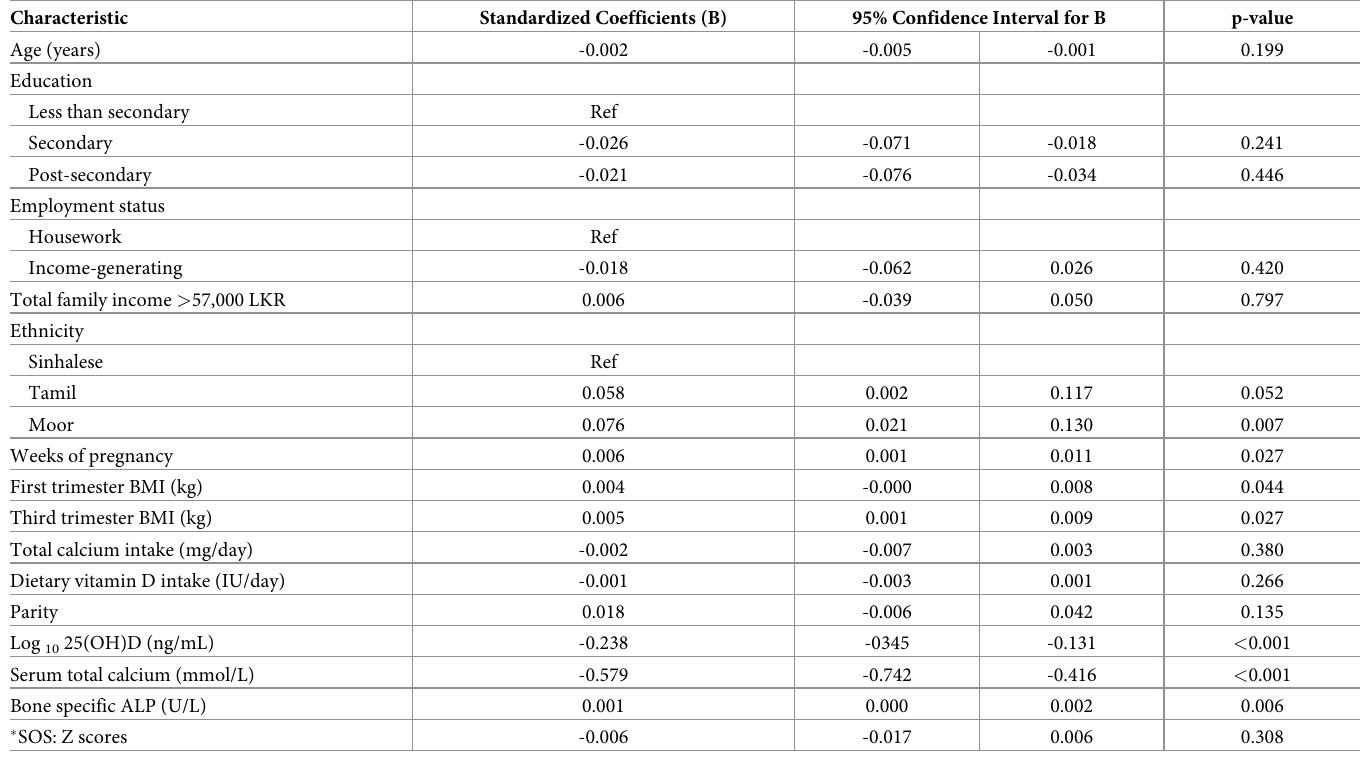
Table 2. Determinants of Log PTH (transformed PTH) concentrations in univariate analysis.